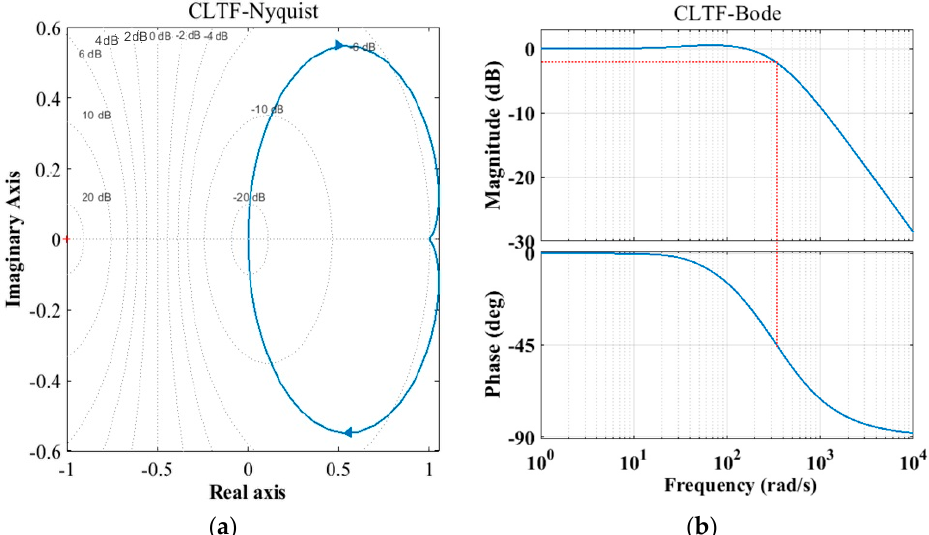
Figure 4. The diagrams of circle Nyquist response ( a ) and bode responses ( b ) of Closed Loop Function Transfer (CLFT).